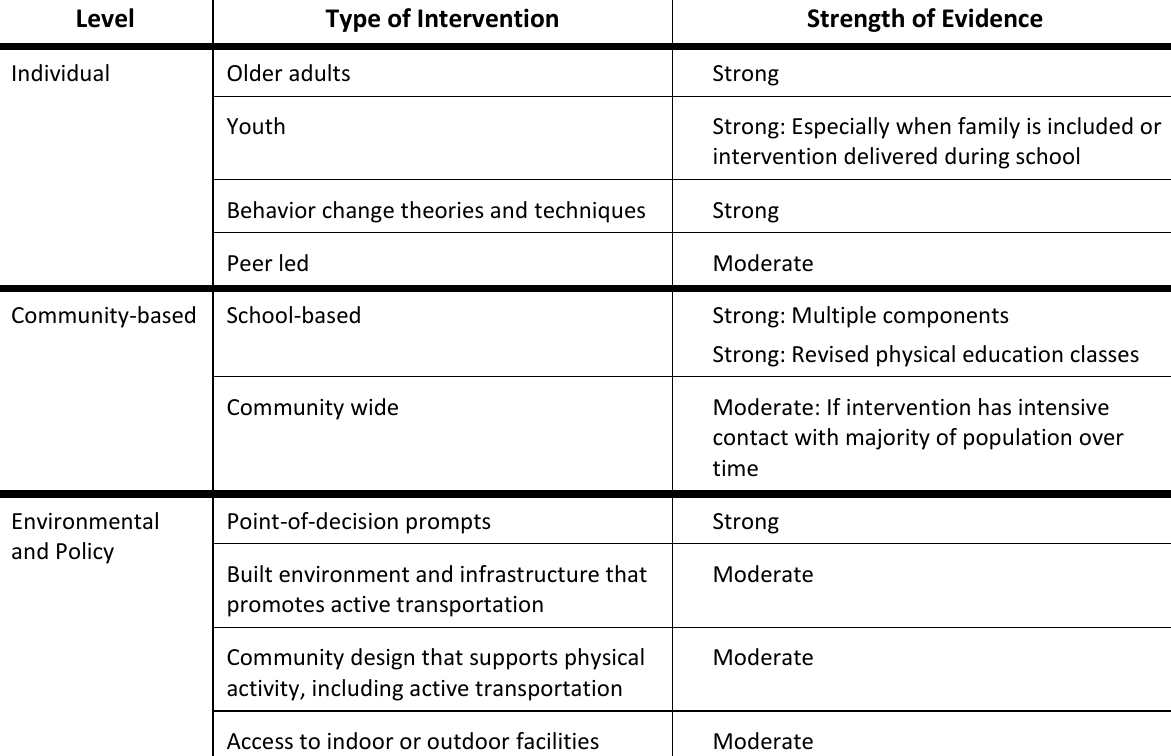
Table D-4. Summary of Conclusion Statements Regarding Strength* of the Evidence that Varying Types of Interventions Increase the Amount of Physical Activity Among Those Who Are Exposed to